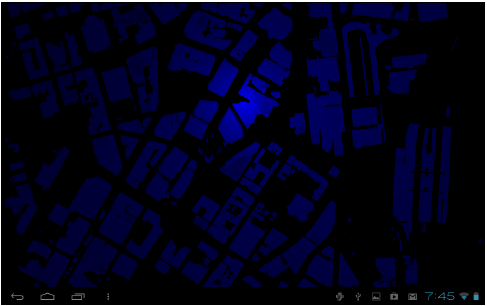
Figure 8: Sheffield - LoD 1 Dataset - Aerial View